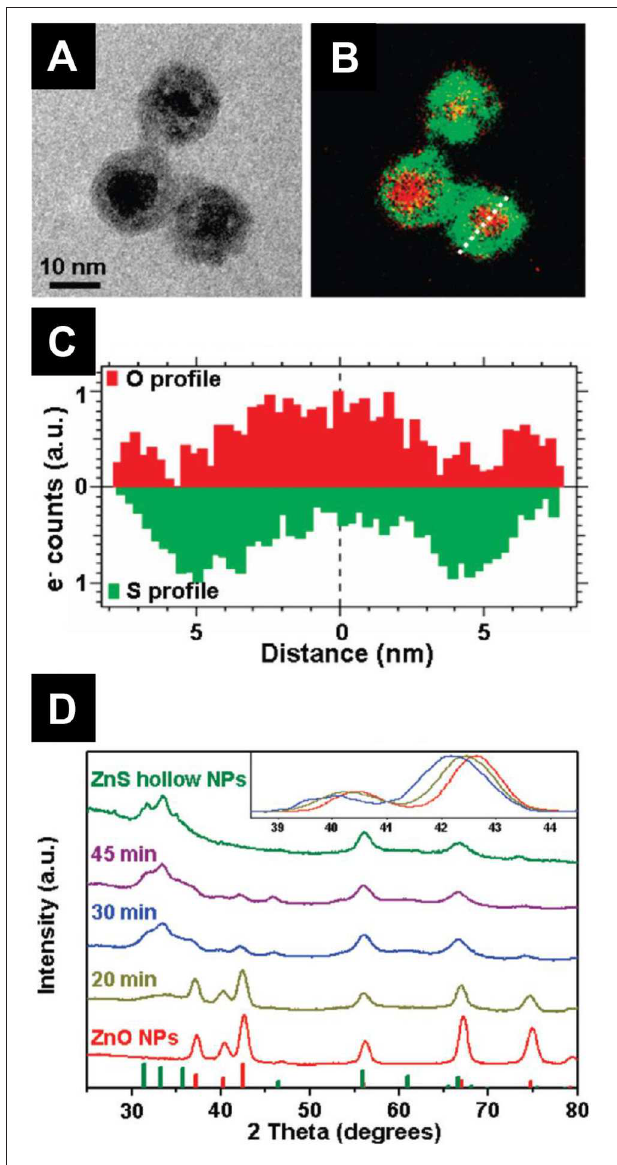
FIGURE 18 | TEM (A) and EFTEM (B) images of ZnO@ZnS nanoparticles. (C) Oxygen and sulfur composition along the cross-section in (B) . (D) XRD patterns of the nanoparticles from ZnO to ZnS through ZnO@ZnS core-shell nanoparticles. Inset: Normalized pattern in the [38.5 ◦ ; 44.5 ◦ ] 2 θ region. The small shifts of the diffraction peaks toward low 2 θ values indicate a lattice dilatation caused by sulfur insertion. Adapted with permission from Park et al. (2009), copyright (2006) American Chemical